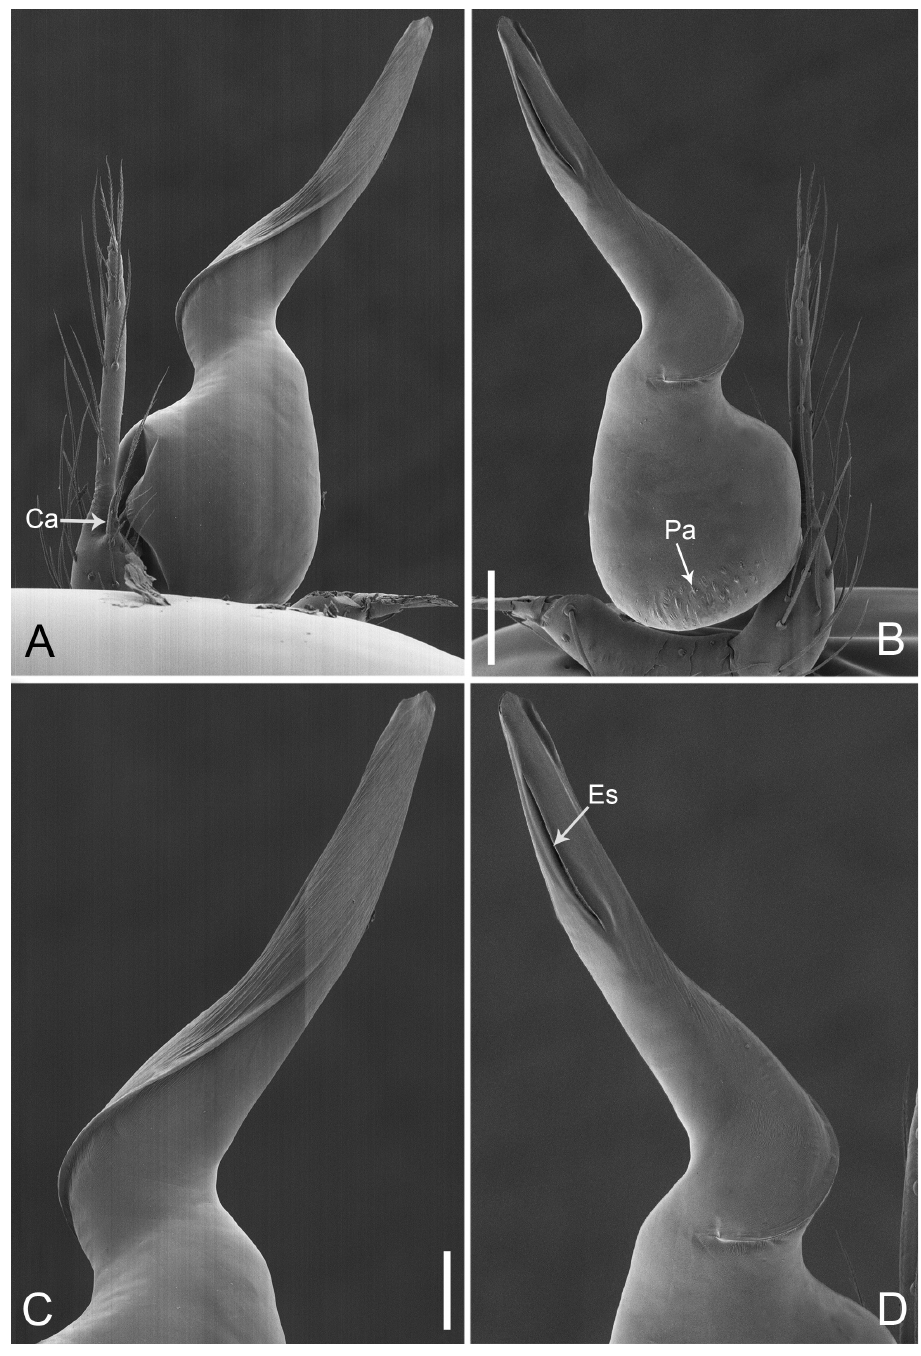
Figure 25. Pinelema yunchuni Zhao & Li, sp. n., male. A Palp, prolateral view B Palp, retrolateral view C Embolus, prolateral view D Embolus, retrolateral view. Scale bars: 0.1 mm ( A–B ), 0.05 mm ( C–D